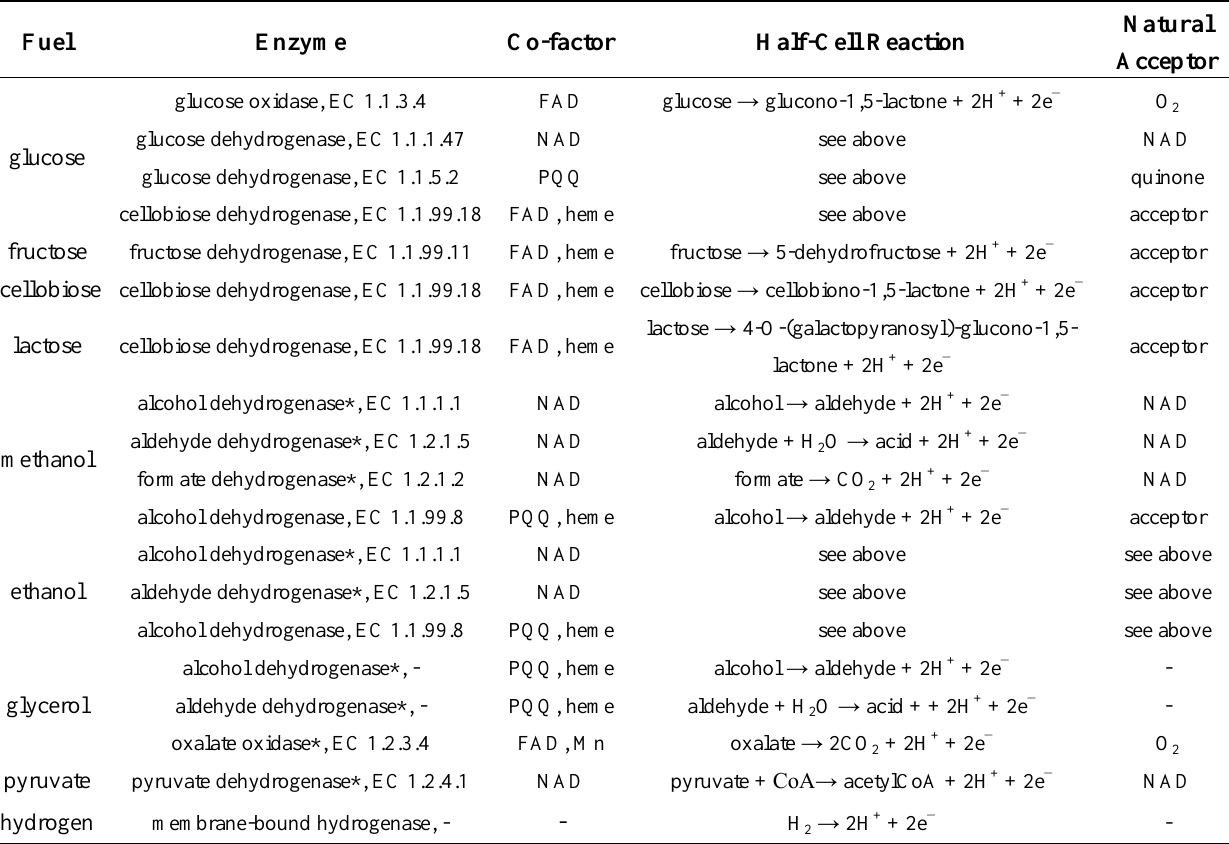
Table 1. Fuels and enzymes used in enzymatic biofuel